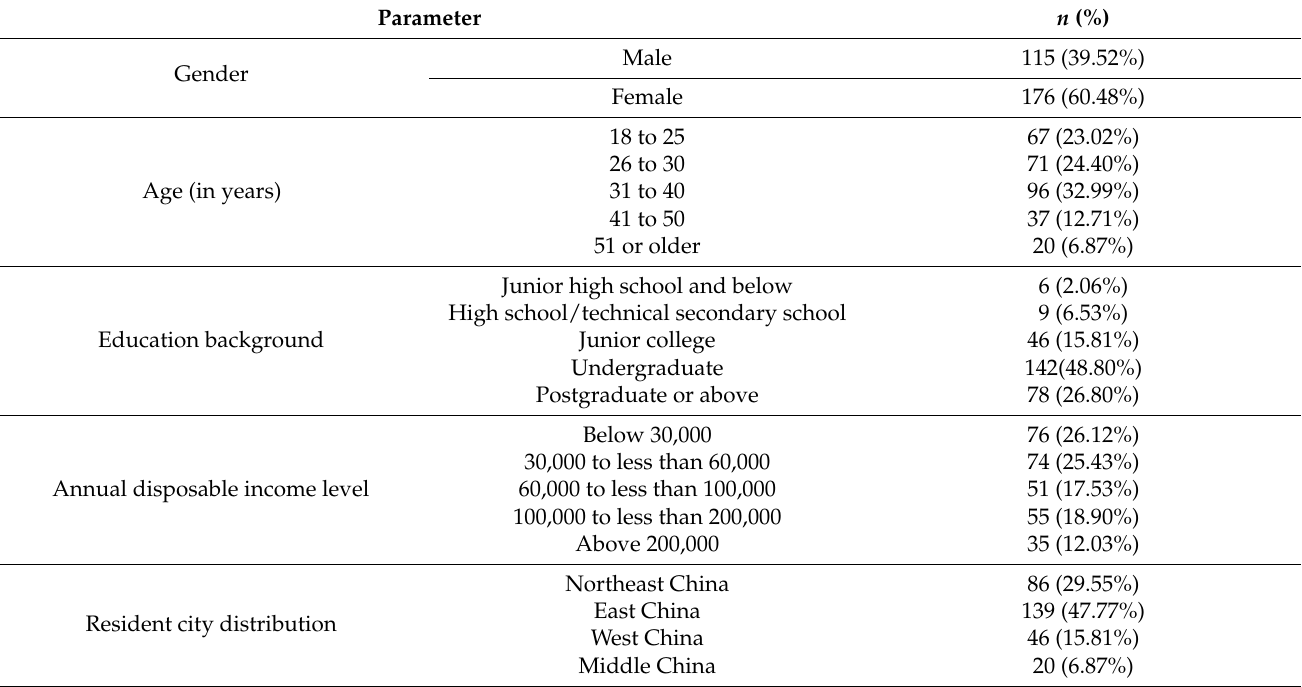
Table 4. Demographic details of respondents ( n = 291).